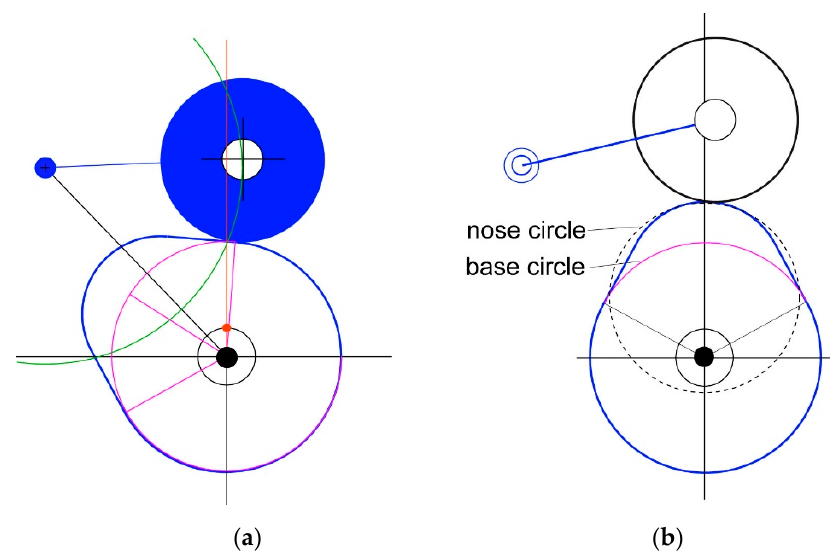
Figure 6. ( a ) Cam-follower mechanism that has been obtained with Dynacam; ( b ) limit configurations with the indications of the base and nose circles in the cam profile.